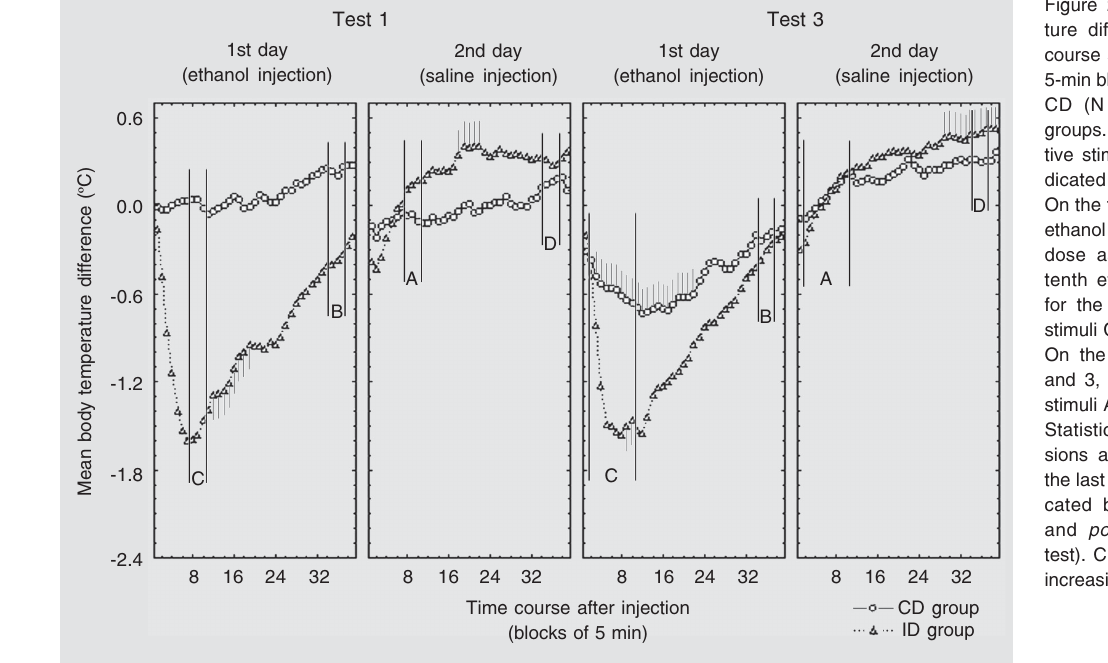
Figure 2. Mean body tempera- ture differences over the time course after injection (shown as 5-min blocks) for tests 1 and 3 in CD (N = 8) and ID (N = 8) groups. The period of exterocep- tive stimulus presentation is in- dicated between parallel bars. On the first day of tests 1 and 3, ethanol was injected at the same dose as that used during the tenth ethanol training session for the respective groups, and stimuli C and B were presented. On the second day of tests 1 and 3, saline was injected and stimuli A and D were presented. Statistical differences for ses- sions and blocks in relation to the last training session are indi- cated by small bars (ANOVA and post hoc Newman-Keuls test). CD = constant dose; ID = increasing